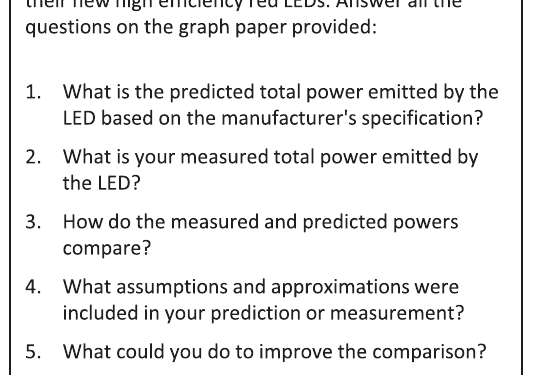
FIG. 3. Written prompts used for the think-aloud experimental activity.